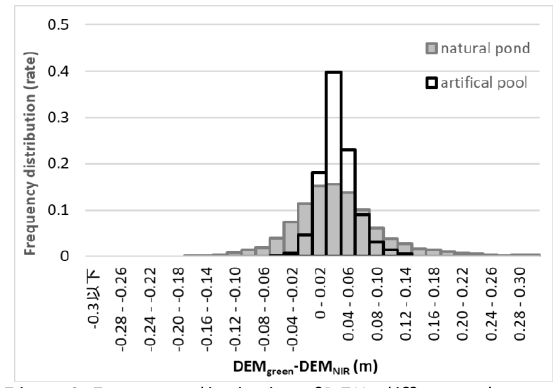
Figure 8. Frequency distritution of DEM differences between NIR laser scanning and green laser scanning The statistics of elevation differences between green laser scanning and NIR laser scanning are summaried in Table 6. Table 6 indicates that the elevation differences of the natural pond is larger than the artificial pool. Min. Max. Mean. Std.Dev. RMSE Natural pond -0.174 Table 6. Statistics of elevation differences between green laser scanning and NIR laser scanning (unit: